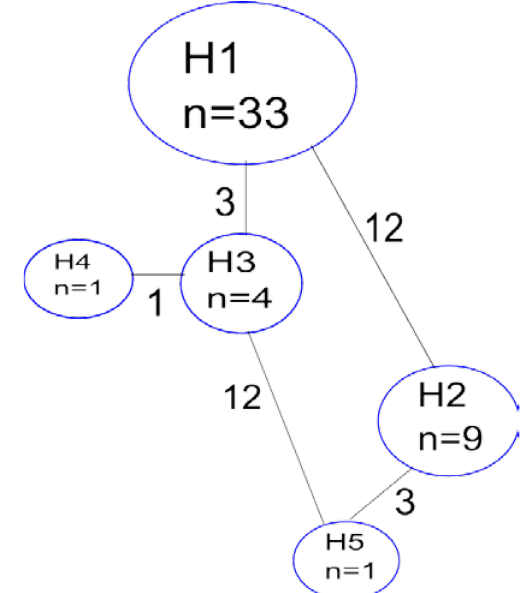
Figure 4. Haplotype network of concatenated calmodulin and β-tubulin sequences. Five haplotypes (H1 to H5) were found. Numbers in circles indicate number of isolates of each haplotype. Numbers of different nucleotides between haplotypes are indicated on the linkage lines between the